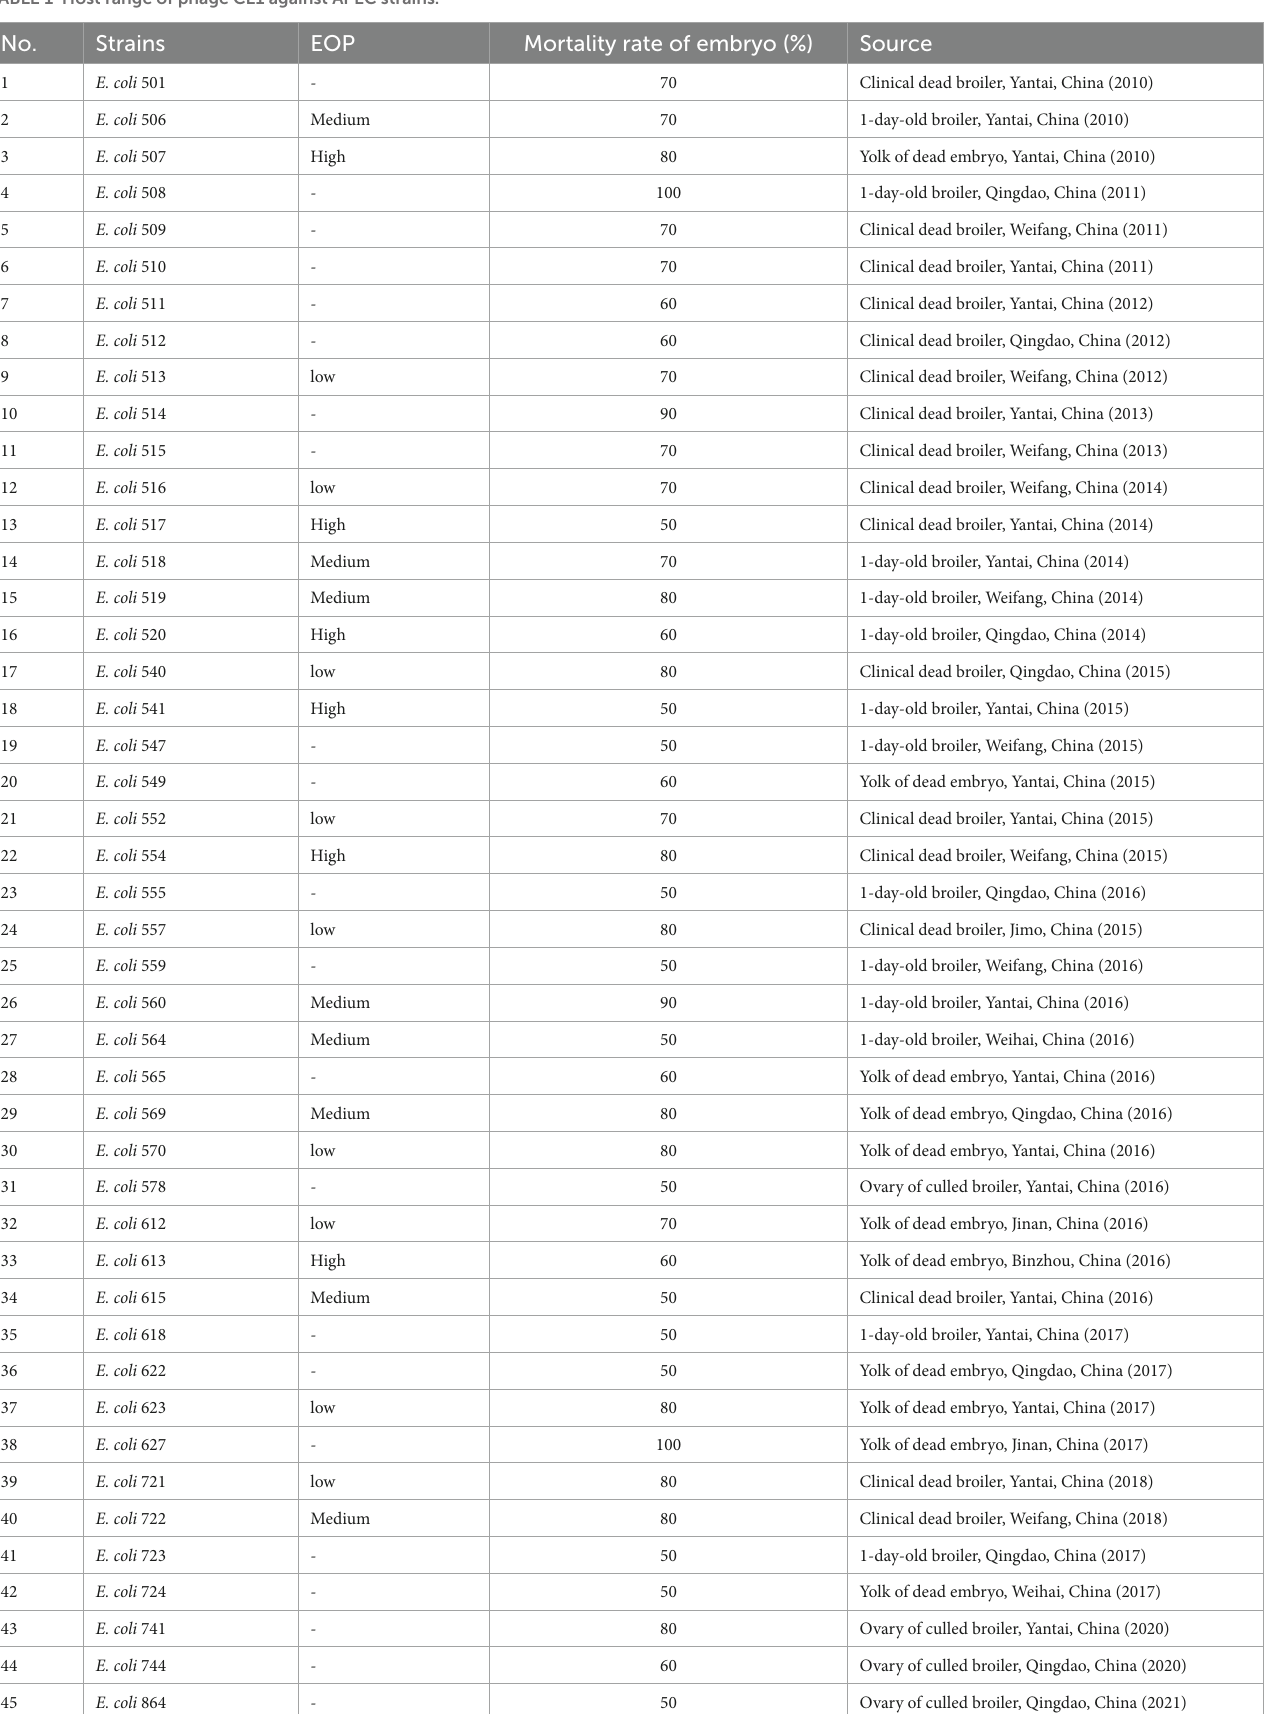
TABLE 1 Host range of phage CE1 against APEC strains. No.